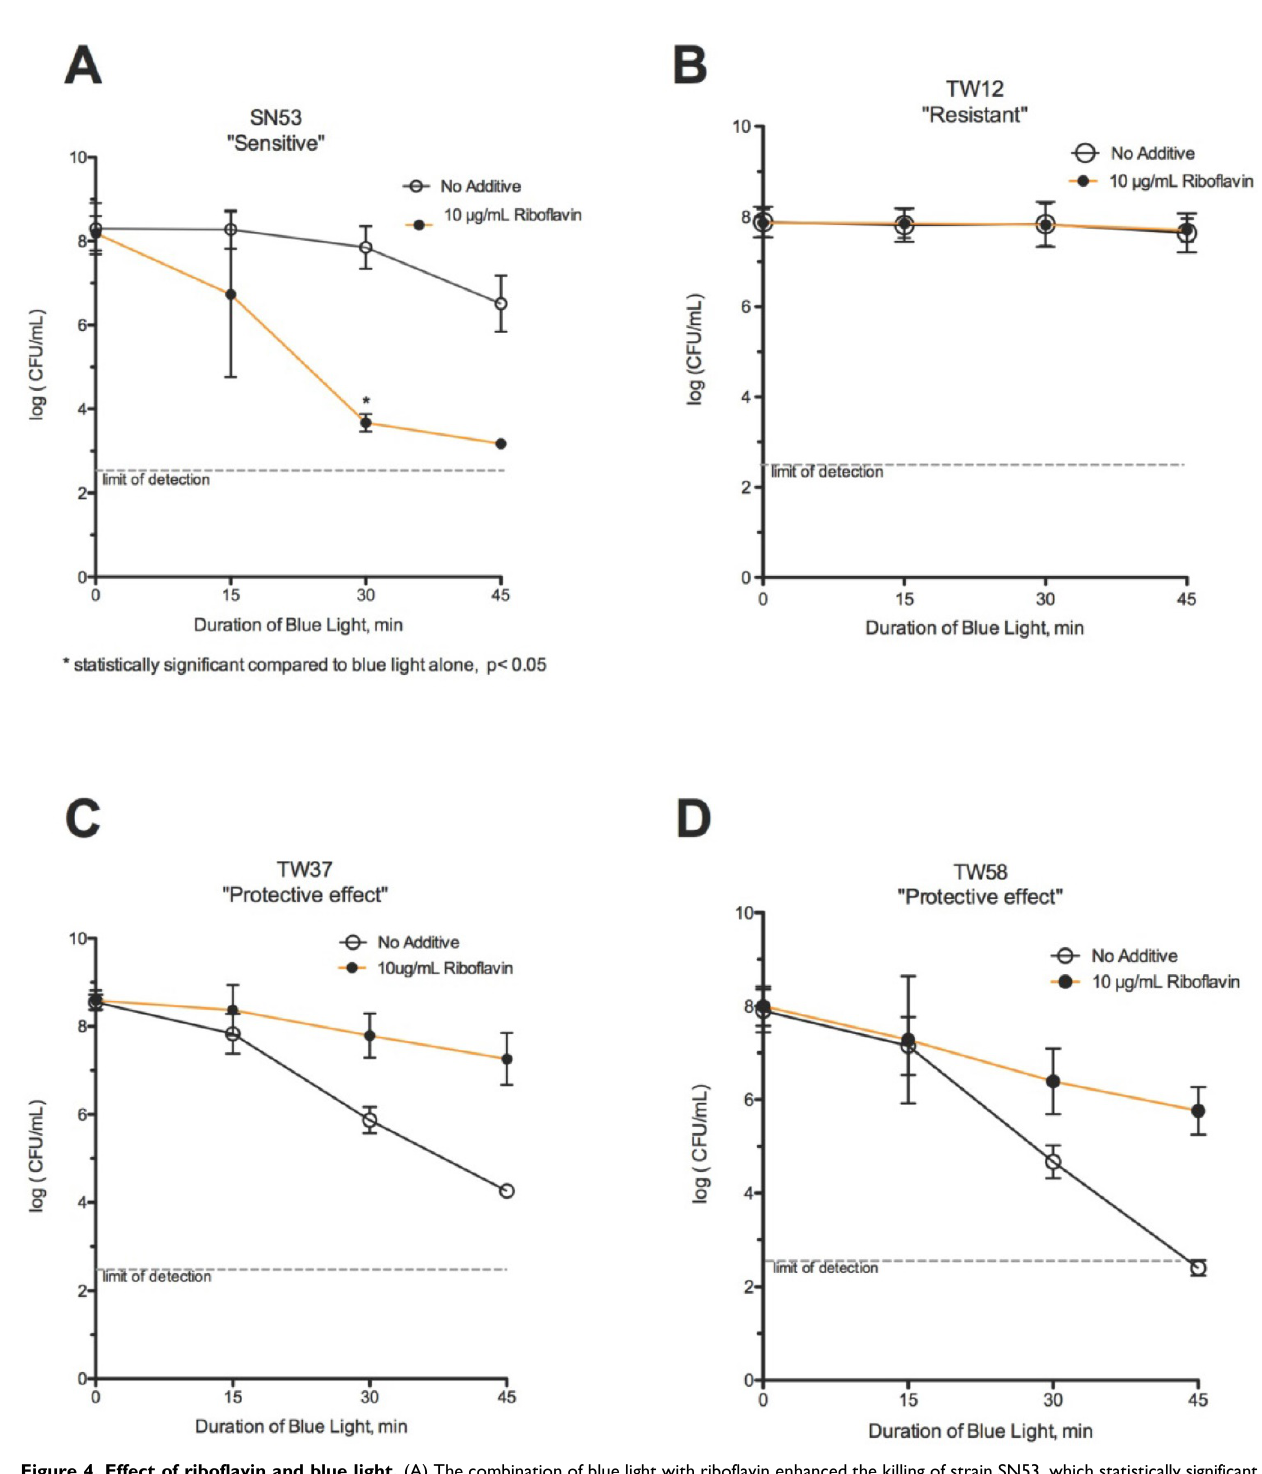
Figure 4. Effect of riboflavin and blue light. (A) The combination of blue light with riboflavin enhanced the killing of strain SN53, which statistically significant based on one tailed t-test analysis compared to blue light alone. (B) Riboflavin did not potentiate killing by blue light in strain TW12, a Resistant strain. In comparison, riboflavin had a protective effect on strains (C) TW37 and (D) TW58, preventing killing by blue